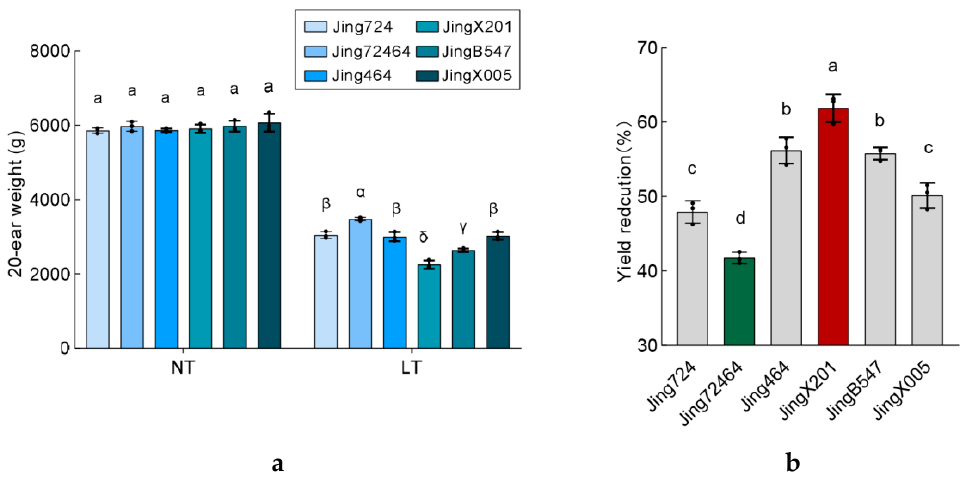
Figure 6. Yield of Jing72464 was less inhibited by low temperature. ( a ) Yield of 6 maize inbred accession in the filed condition under LT or NT. Data represent meanvalues of three independent replicate ( n > 10). Significant differences were labeled with different Roman (a, b, c) or Greek letters ( α , β , γ ). ( b ) Yield reduction ratio was calculated as the yield in LT versus that in